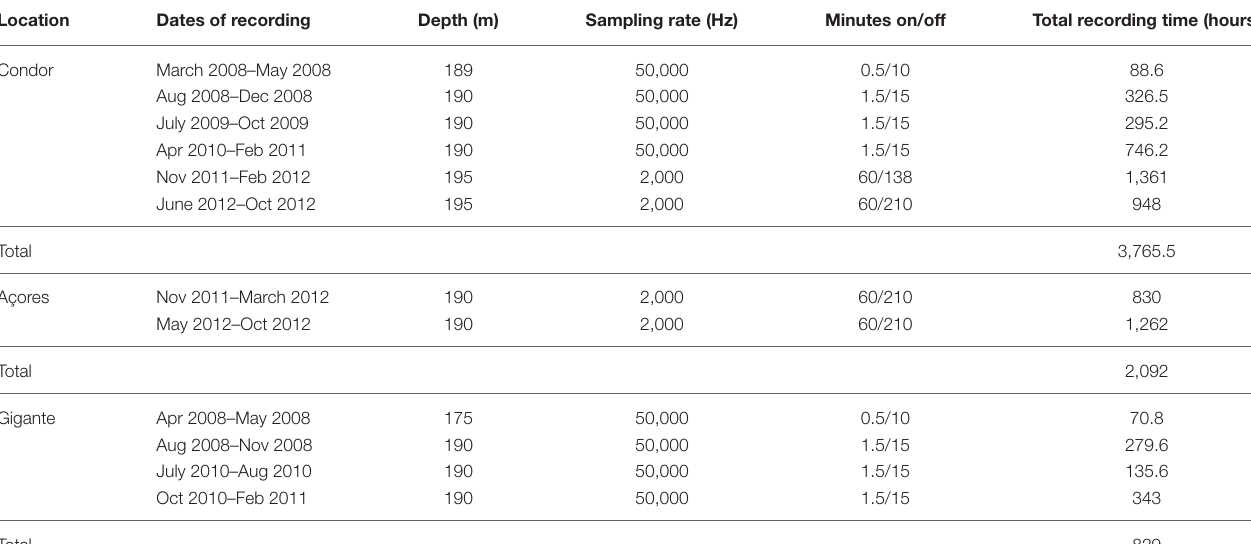
TABLE 1 | Summary of acoustic data used in this work including recording dates, deployment depth, sampling rate, duty cycle, and total recording time.